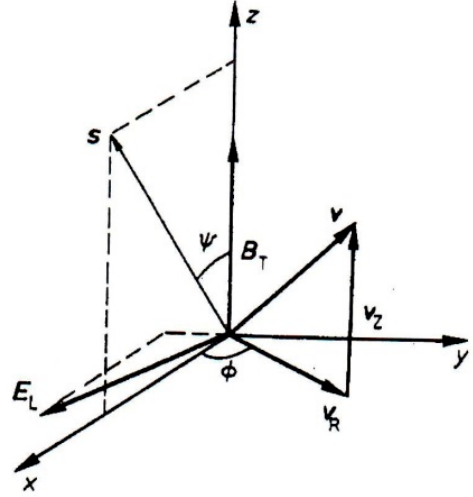
Figure 5. Relative configuration of the magnetic B and Lorentz E L fields and of the direction of the observation s (“s” stands for “spectrometer”). The z axis is along B . The direction of the observation s constitutes a non-zero angle ψ with B . The xz plane is spanned on vectors B and s . The atomic velocity v has a component v z along B and a component v R perpendicular to B . The component v R constitutes an angle φ with the x axis [66].